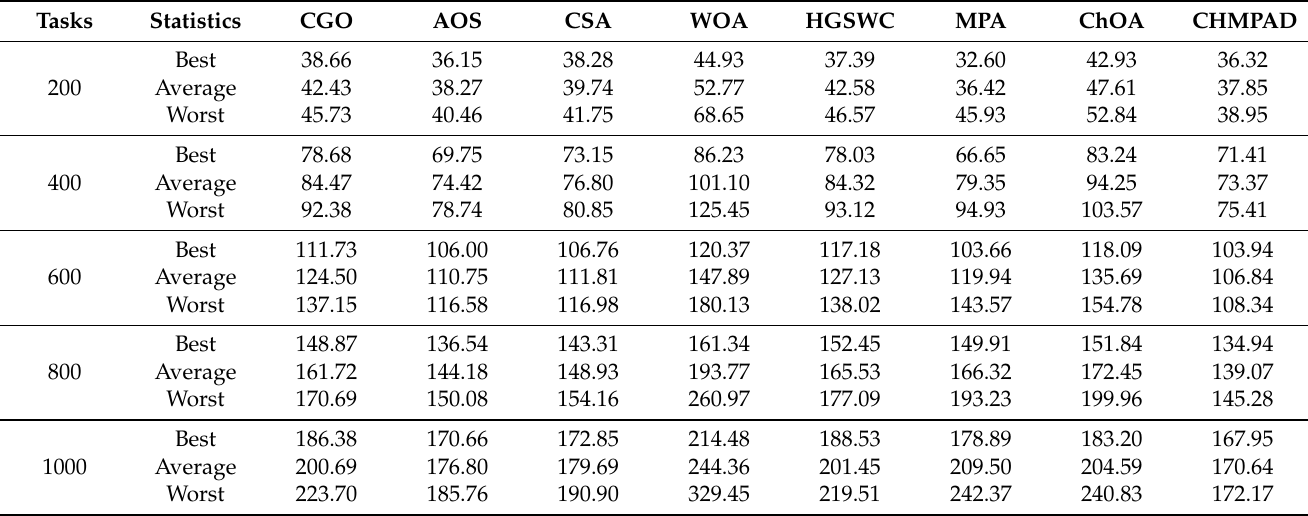
Table 3. Makespan values of CHMPAD algorithm and compared algorithms—synthetic workload.